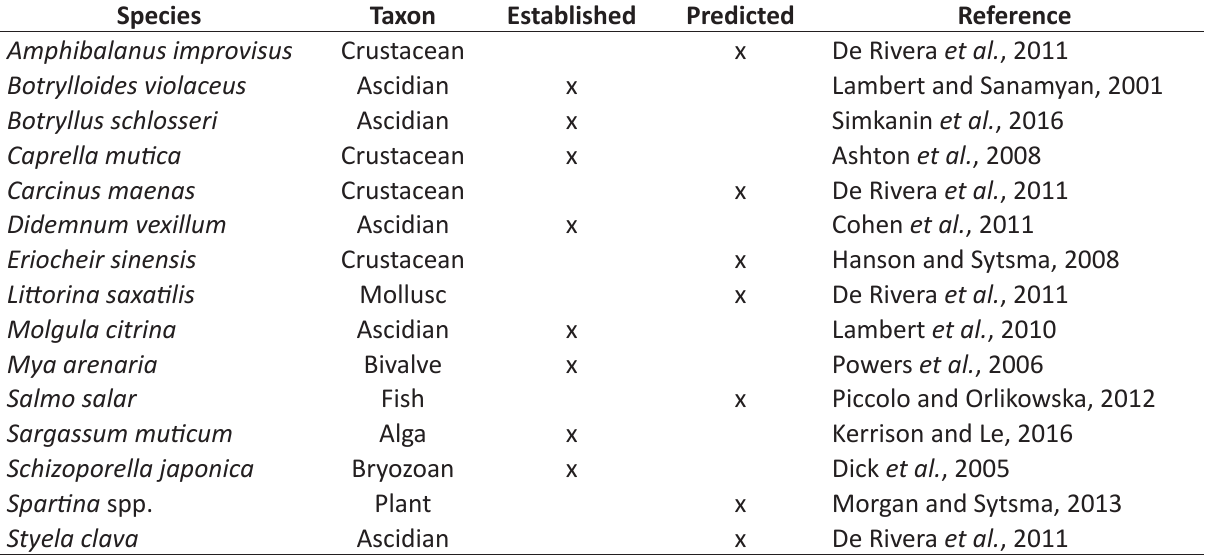
Table 2. Invasive species established or predicted to colonize Alaska based on a structured literature